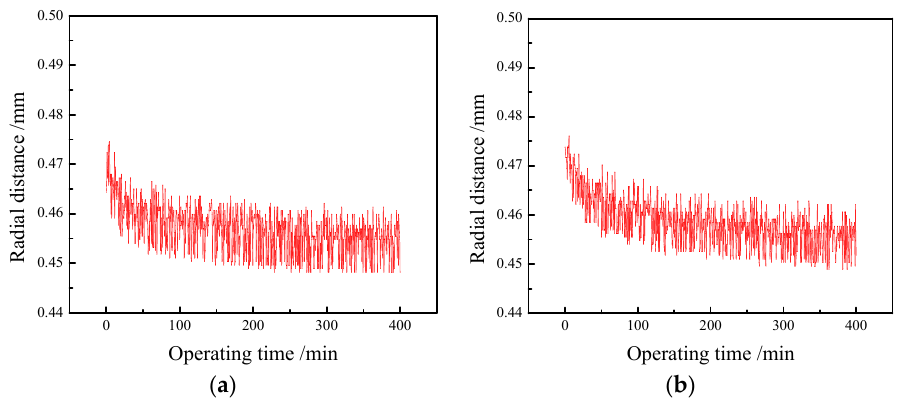
Figure 12. The variation of oil ‐ film thickness from displacement transducer H2 with time at 150 rpm ‐ 6 MPa. ( a ) S220; ( b ) M220.